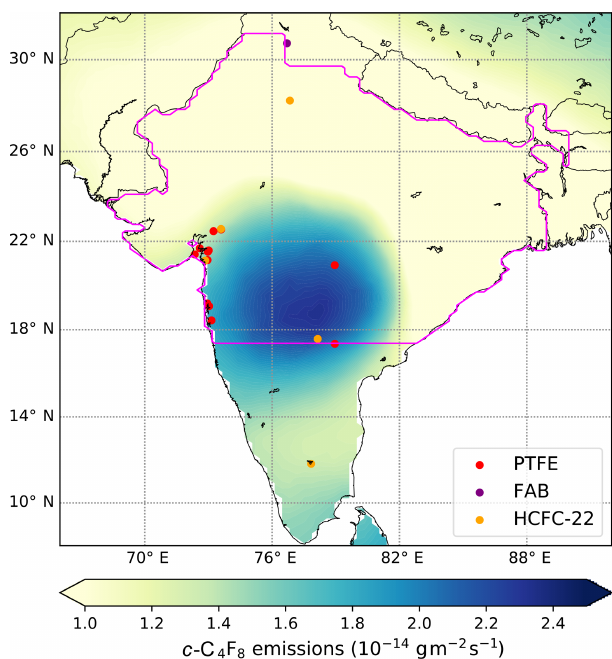
Figure 9. Mean c -C 4 F 8 emission strength (shades of green and blue, 10 − 14 gm − 2 s − 1 ) over the Indian subcontinent for June and July 2016 determined by the NAME-HB inversion based on air samples taken on board UK’s FAAM (Facility for Airborne Atmo- spheric Measurements) BAe-146 research aircraft. Also shown are the locations of one semiconductor fabrication plant (FAB, purple dot) and several potential TFE–HFP–PTFE–FEP production facil- ities (PTFE, red dots, Solvay/CYTEC, Hindustan Fluorocarbons, and Gujarat Fluorochemicals facilities) as potential c -C 4 F 8 sources. HCFC-22 (orange dots) production facilities are also shown as the TFE and HFP monomers needed to produce PTFE and FEP fluo- ropolymers are produced via pyrolysis of HCFC-22 and c -C 4 F 8 is an intermediate/by-product in this process. The outline of the north- ern and central India (NCI) model domain is shown as a pink